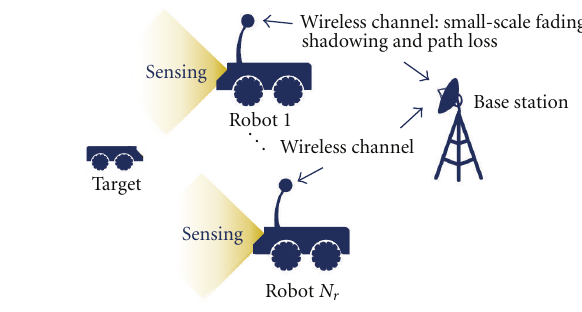
Figure 14: Cooperative target tracking over realistic communica- tion links